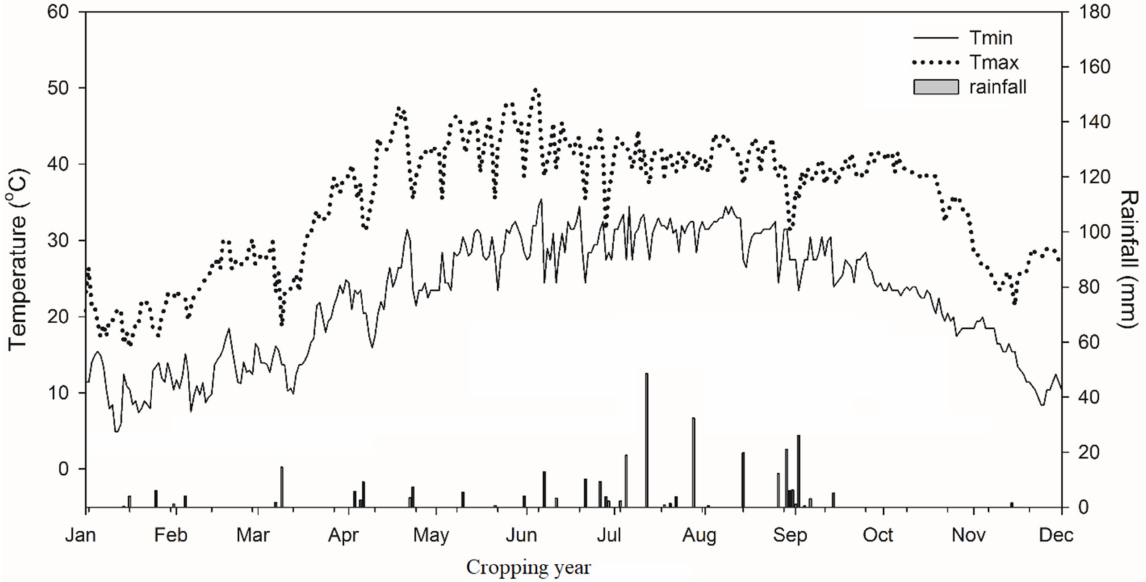
Figure 1. Climatic conditions of the study area during